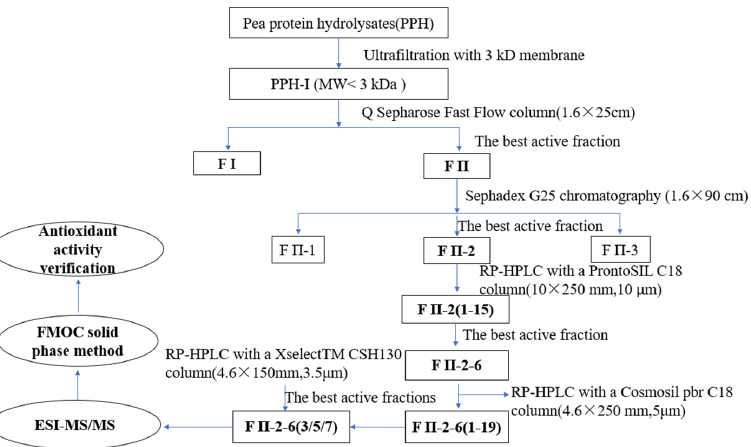
Figure 1. The flow chart of purifying antioxidant peptides from pea proteins hydrolysates. F II, F II-2, F II-2-6, and F II-2-6(3/5/7) are the active peak components determined by the Q Sepharose FF, Sephadex G-25, Pronto SIL C18 column, and Cosmosil pbr column, respectively.